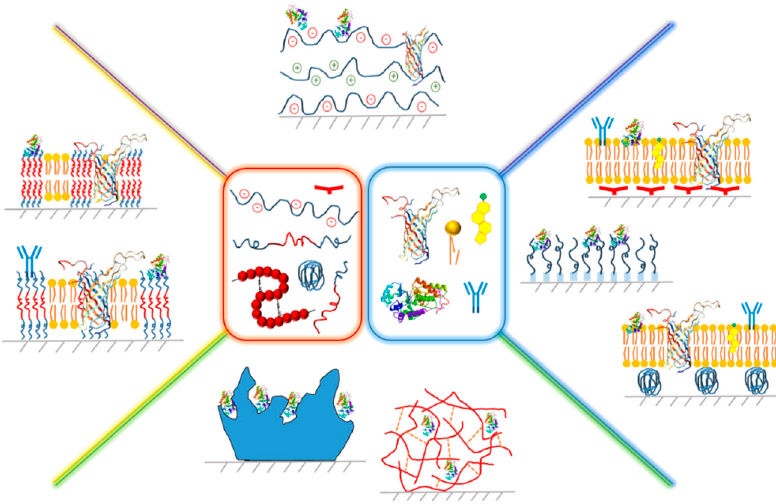
Figure 1. Schematic presentation of biomimetic hybrid films based on the combination of biomolecules (enzymes, proteins, nucleic acids, natural polymers, and lipids) and different polymer species: polyelectrolytes ( top ), polymeric structures (brushes, tethers, and cushions) ( right ), synthetic polymers ( bottom ), and amphiphilic block copolymers ( left ).